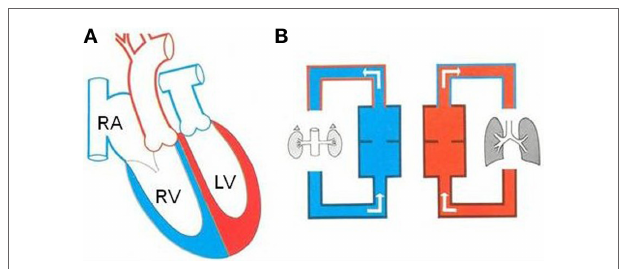
FigUre 1 | complete Tga in atrial situs solitus . (a) Diagram illustrating complete TGA with situs solitus and concordant AV connection. (B) The systemic and pulmonary circulations are in parallel. LV, left ventricle; RA, right atrium; RV, right